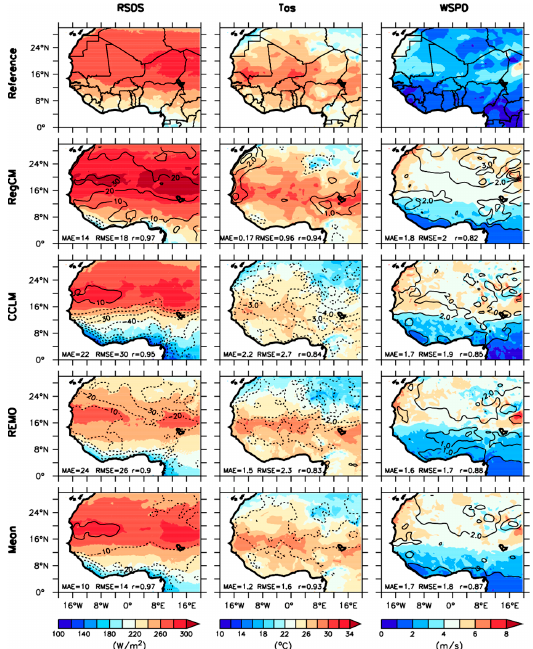
Figure 3. Spatial distribution of the annual averages of observed and simulated solar irradiance (RSDS), ambient air temperature (Tas), and surface wind speed (WSPD) over West Africa. The bias is plotted in contours, and the correlation (r), mean absolute error (MAE), and root mean square error (RMSE) between the observation and the model are also indicated. Energies 2022 , 15 , 9602